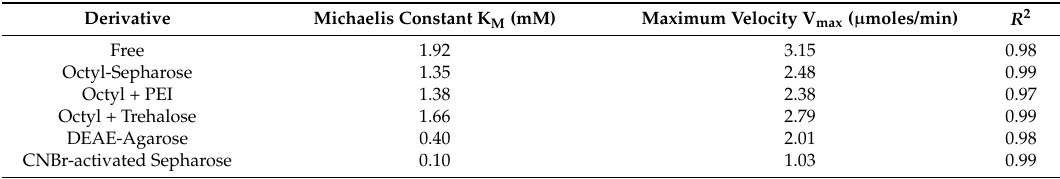
Table 2. Kinetic constants of M. spathulata R25L270 lipase immobilized on different supports, determined by hydrolysis of